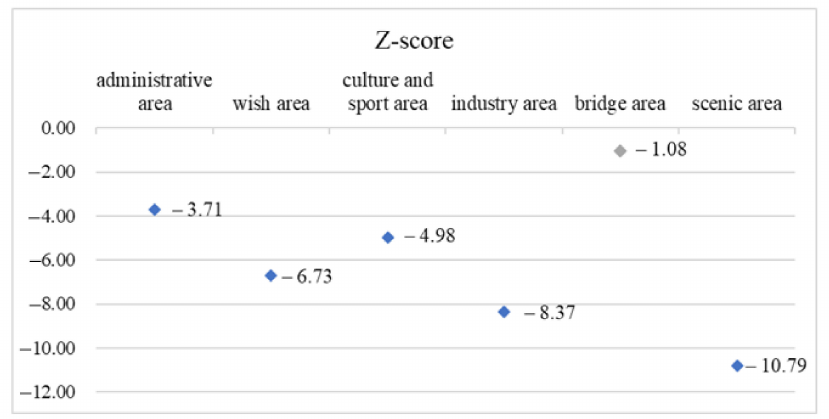
Figure 10. The averaged nearest neighbor analysis results of main type street names.